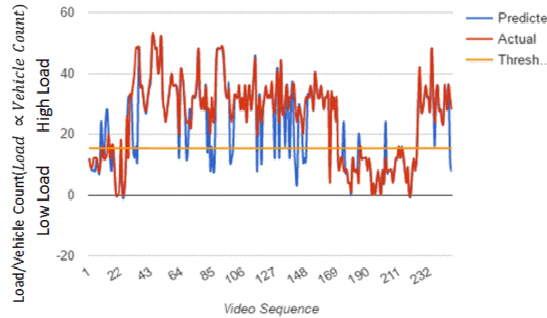
Figure 7. Online Analysis